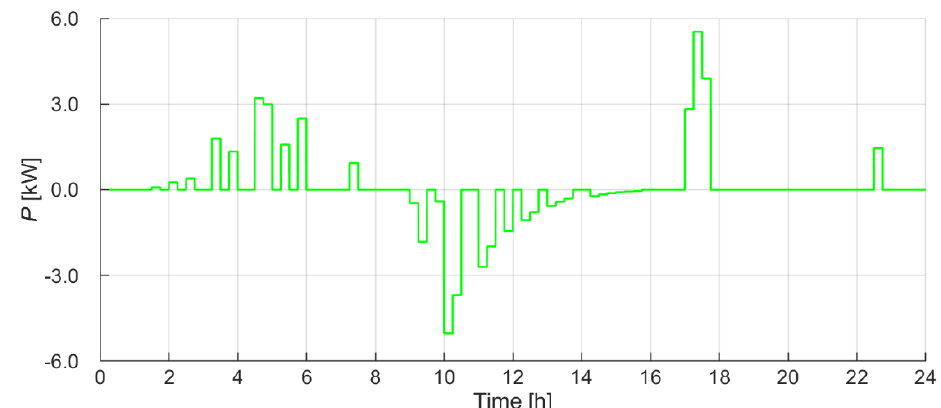
Figure 19. Daily active power variation of the energy storage unit ES_529 (installed in node 529); profile B.